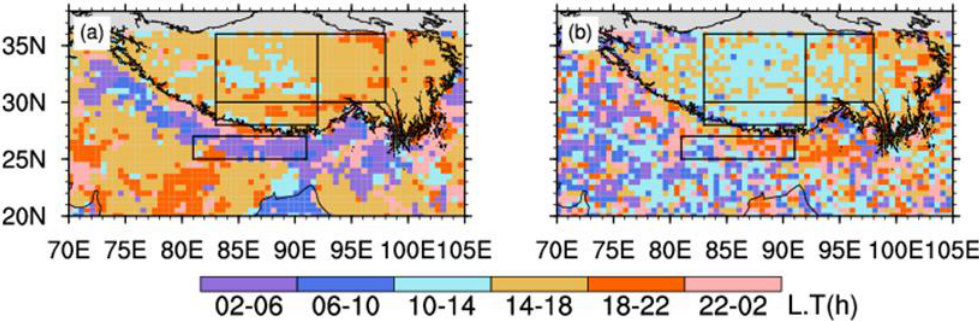
Figure 5. The distribution of time peak for ( a ) frequency and ( b ) rain rate of DCP in summer over the QTP and its southern regions calculated from observations of TRMM PR from 1998 to 2012. The black boxes marked in each panel are seen in Figure 1. Note: (1) the measurement time of PR was converted to local time (LT). (2) A day was divided into six periods: early morning (02:00–06:00 L.T), forenoon (06:00–10:00 L.T), noon (10:00–14:00 L.T), afternoon (14:00–18:00 L.T), evening (18:00–22:00 L.T), and midnight (22:00–02:00 L.T).